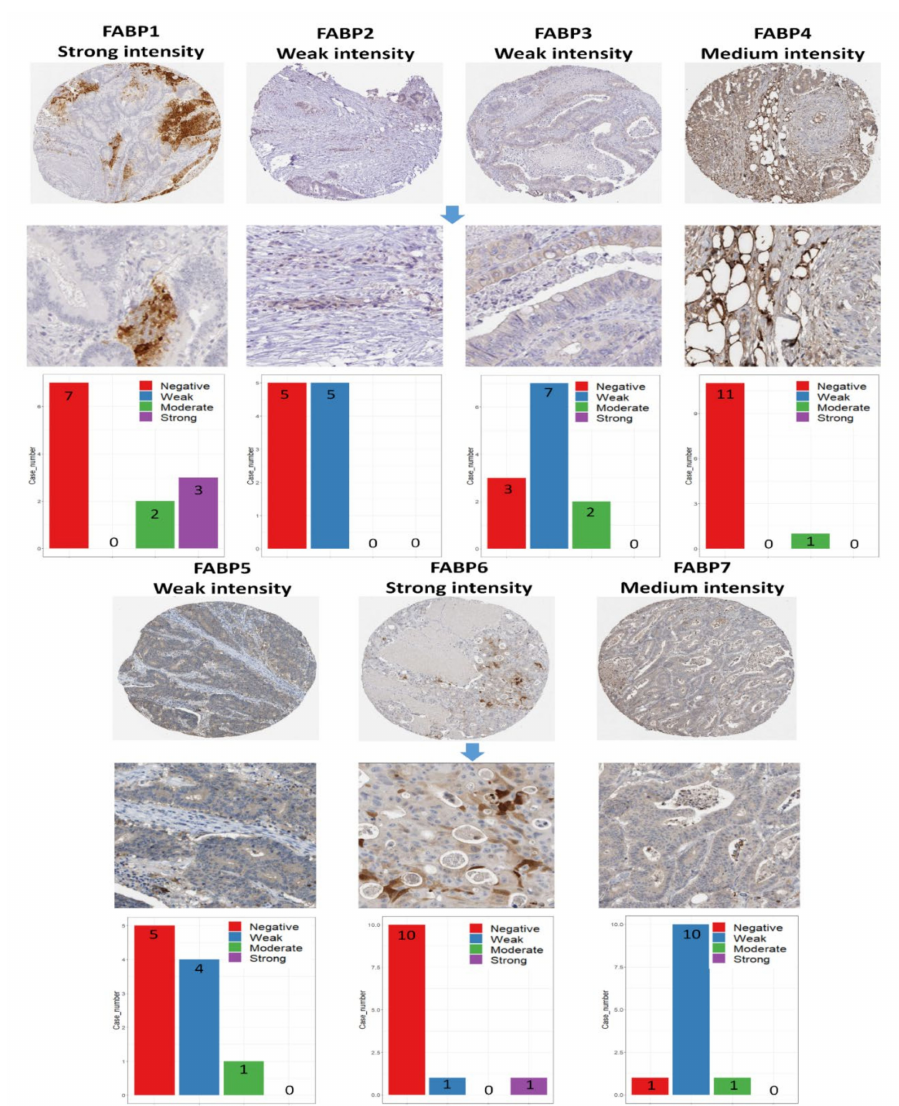
Figure 6. Analysis of protein expression using the HPA database in CRC tissue samples. The representative images of immunohistochemistry of FABP genes show their staining intensity, and the bar charts represent the quantification of IHC staining in CRC samples. Manual scoring of immunohistochemistry data for staining intensity (negative, weak, moderate, or strong) and proportion of stained cells (25 percent, 25–75 percent, or >75 percent) determined the protein expression score. FABP1 (11 patients), FABP2 (10 patients), FABP3 (12 patients), FABP4 (12 patients), FABP5 (10 patients), FABP6 (12 patients), and FABP7 (12 patients). FABP1 and FABP6 showed strong protein expressions in CRC, whereas FABP2, FABP3, FABP4, FABP5 , and FABP7 showed low protein expressions in